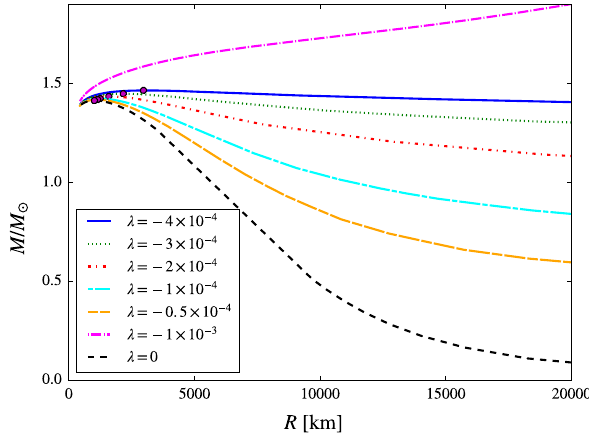
Fig. 1 Total mass as a function of the total radius for different values of λ . The full magenta circles indicate the maximum mass points